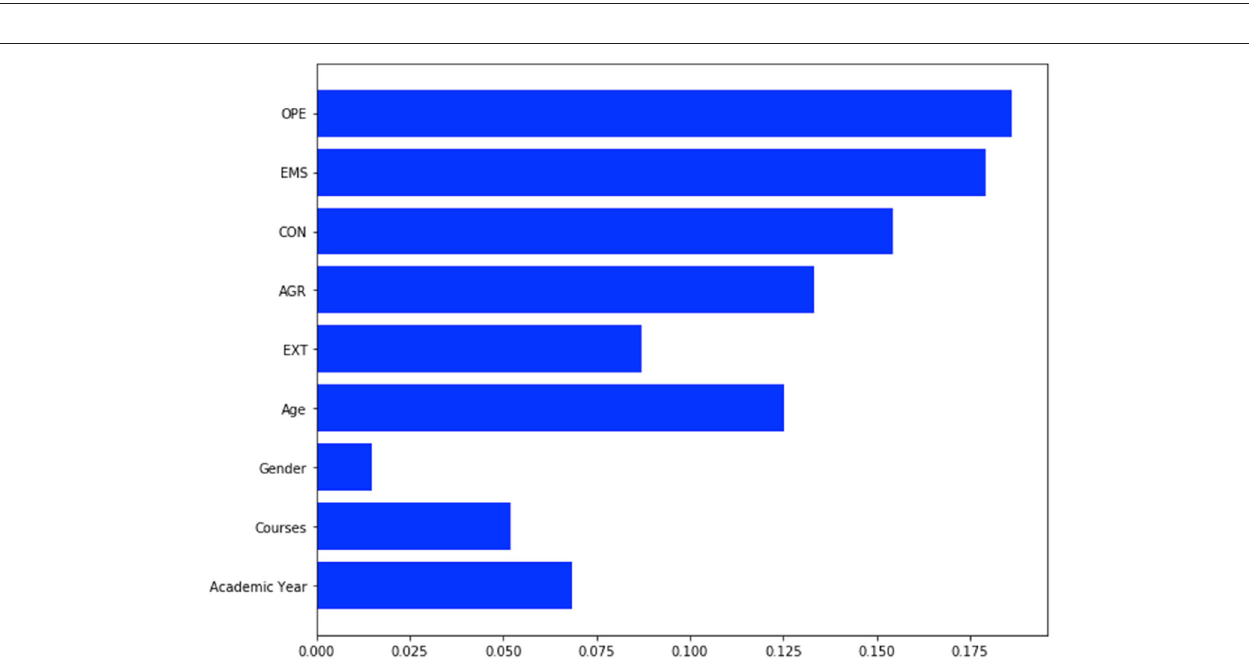
FIGURE 2 | GBR prediction model for Anger item. OPE, Openness; EMS, Emotional Stability; CON, Conscientiousness; AGR, Agreeableness; EXT, Extraversion. Accuracy for Anger is 0.709.